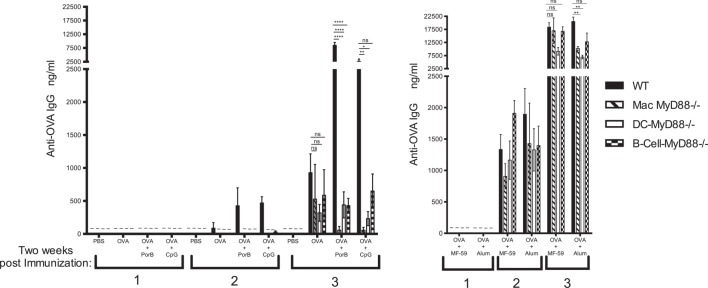
Intact in vivo MyD88 signaling in B cells, dendritic cells (DCs), or macrophages is required for robust vaccine-induced humoral responses by toll-like receptor (TLR)-based adjuvants. Total ovalbumin (OVA)-IgG concentrations were measured by enzyme-linked immunosorbent assay (ELISA) following immunization with (A) PBS, OVA alone or mixed with TLR-dependent adjuvants PorB, CpG or (B) with TLR-independent adjuvant MF59 or alum. Wild-type, Mac-MyD88−/−, DC-MyD88−/−, and B-cell-MyD88−/− mice, respectively, were immunized three times at 2-week interval. The results shown are from samples collected 2 weeks after each immunization and representative of two experiments with a total of four to eight mice per immunization. Statistics were calculated based on a non-parametrical one-way ANOVA with Tukey’s test (ns, not significant P > 0.05, *P < 0.05, **P < 0.01, ***P < 0.001, and ****P < 0.0001). Symbol (–) indicates that IgG levels were below detectable level.